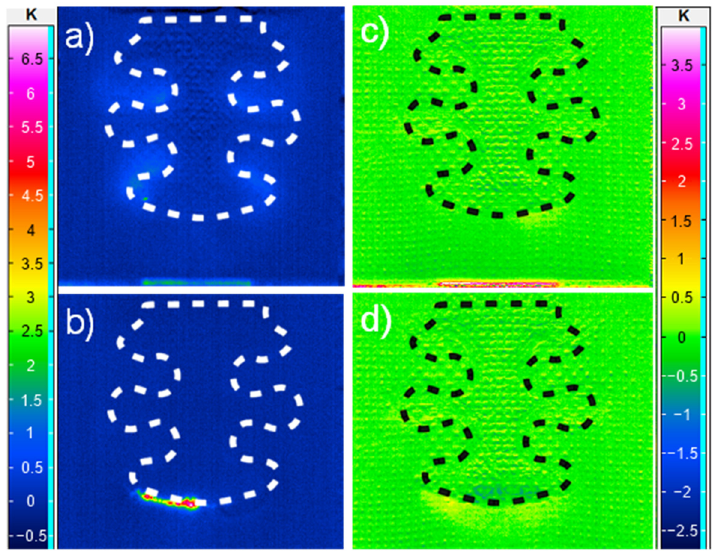
Figure 7. ∆ T-thermograms of two consecutive frames (0.33 s time difference) of each temperature during a damage event: ( a ) first frame 23 ◦ C, ( b ) second frame 23 ◦ C, ( c ) first frame 60 ◦ C, ( d ) second frame 60 ◦